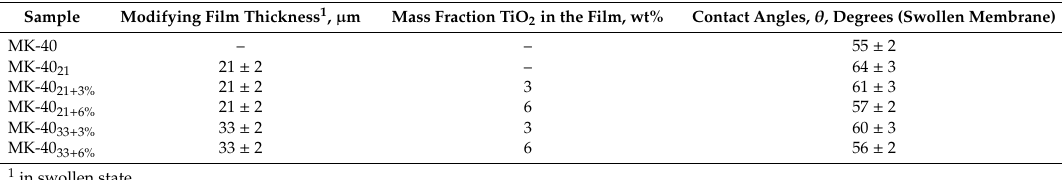
Table 1. Studied membranes and some